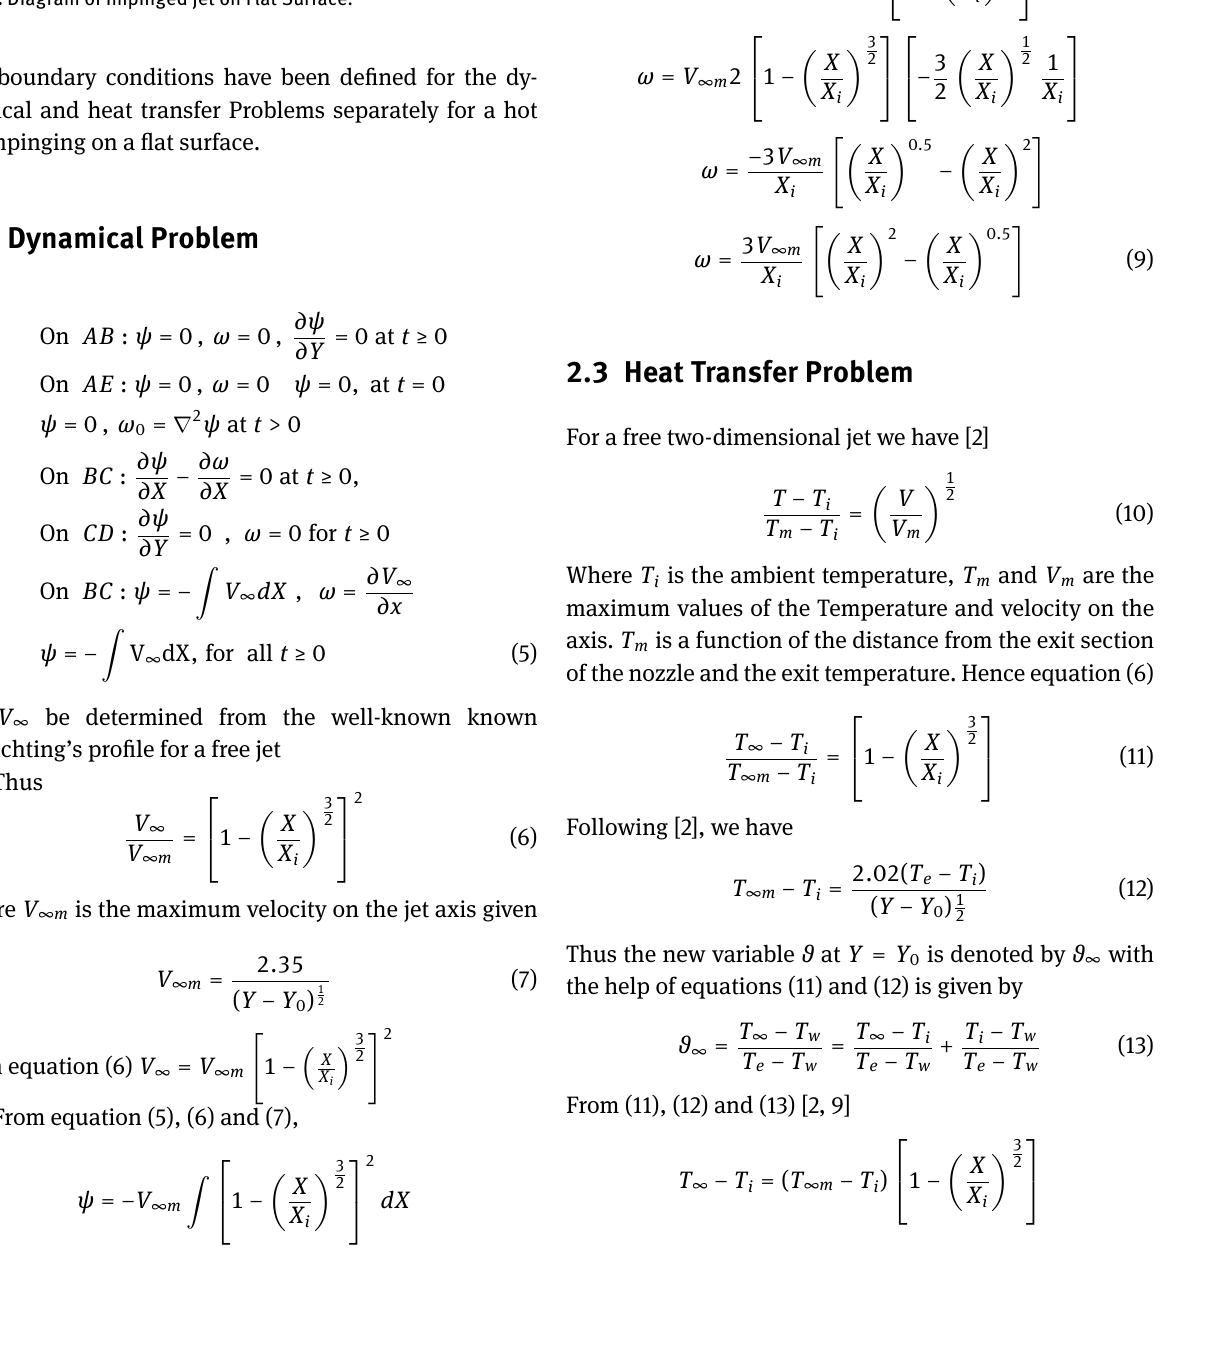
Fig. 2. Diagram of Impinged jet on Flat Surface.